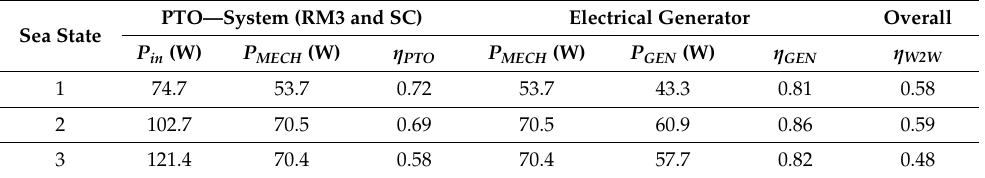
Table 8. Efficiencies at different stages of energy conversion chain for regular waves. PTO—System (RM3 and SC) Electrical Generator Overall Sea State